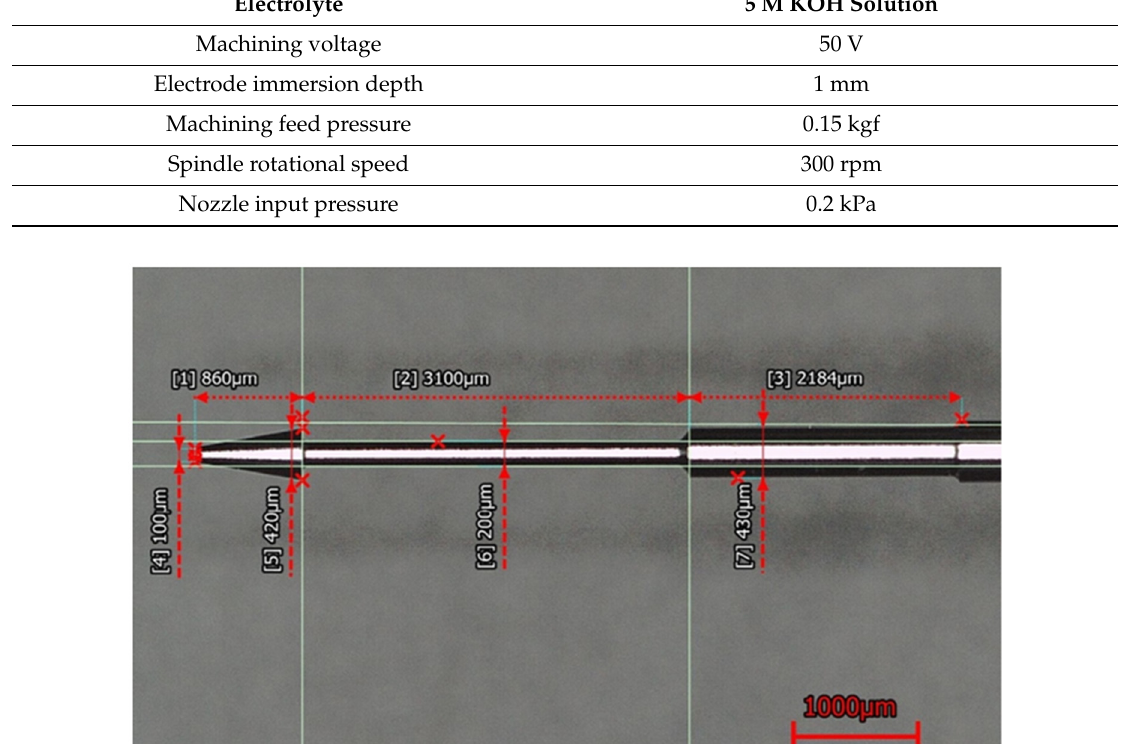
Table 1. Experimental parameter settings.